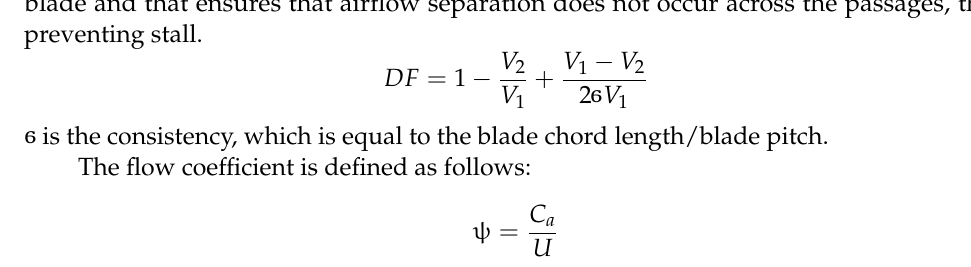
Figure 1. Velocity Figure 1. Velocity triangle. Figure 1. Velocity triangle.